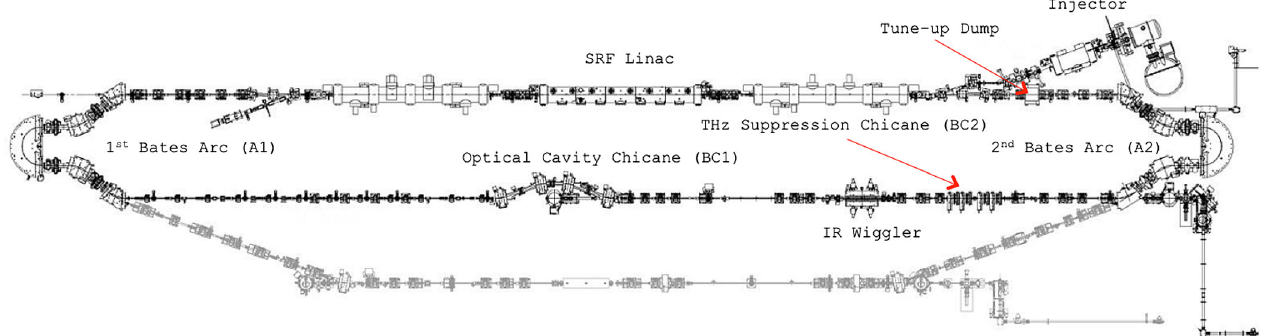
FIG. 1. Layout of the FEL at Jefferson Laboratory. The IR FEL system, shown in black, was used for these measurements. The gray is the UV line and was not used in this experiment.